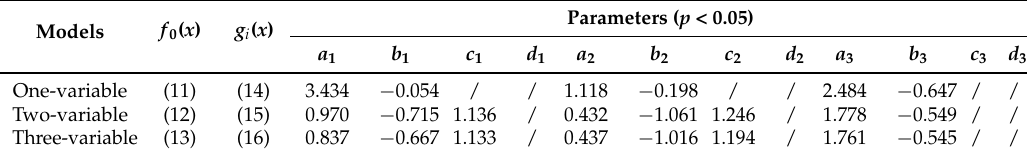
Table 6. Parameters for the “branches system” of additive biomass